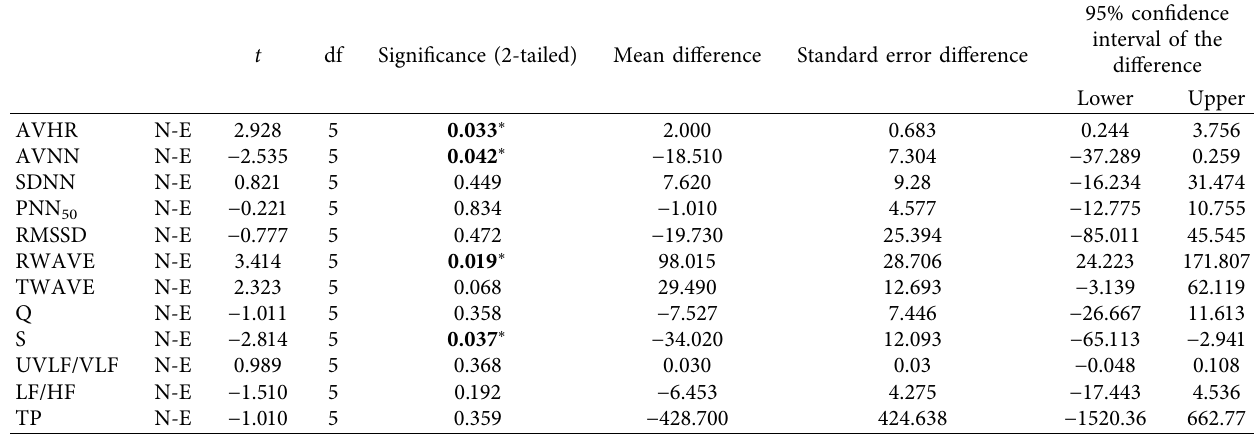
Figure 13: Young and middle age drivers’ ECG characteristics in anxiety. (a) Female ∗ novice ∗ extraversion. (b) Female ∗ novice ∗ middle type. (c) Female ∗ novice ∗ introversion. (d) Male ∗ novice ∗ extraversion. (e) Male ∗ novice ∗ middle type. (f) Male ∗ novice ∗ introversion (I, AVHR; II, AVNN; III, SDNN; IV, PNN 50 ; V, RMSSD; VI, RWAVE; VII, TWAVE; VIII, Q; IX, S; X, UVLF/VLF ∗ 1000; XI, LF/HF ∗ 100; XII, TP). Table 8: Independent t -test results of ECG characteristics for novice and experienced drivers in